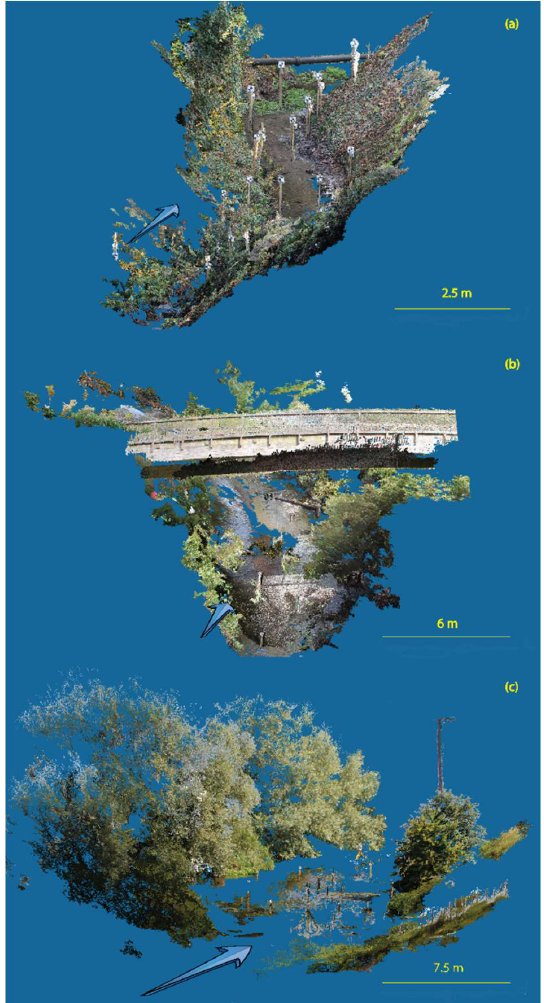
Figure 10. Structure-from-Motion (SfM) generated point cloud obtained for each of the 40 m long study reaches: ( a ) Chicheley Brook; ( b ) River Ouzel; and ( c ) River Great Ouse. The images illustrate the proportion of the point cloud representing vegetated and un-vegetated banks, as well as any artificial structures along/across the reach. The arrows indicate downstream flow direction.